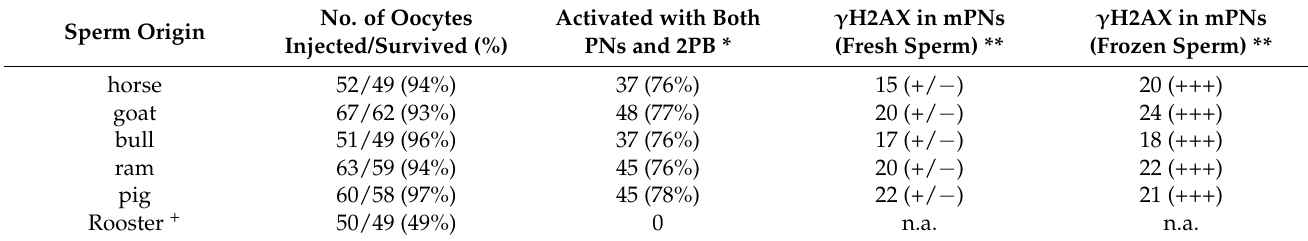
Table 1. Xenogenic sperm head injection into mouse ovulated